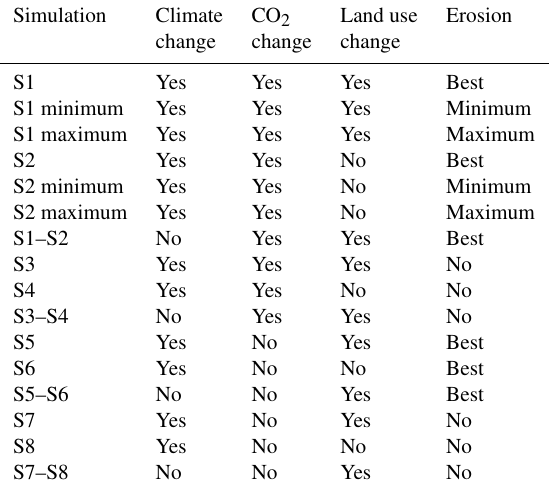
Table 1. Description of the simulations used in this study. The S1 simulation is also the control simulation (CTR). S1 and S2 mini- mum and maximum are the sensitivity simulations using minimum or maximum soil erosion rates. “Best” stands for the best estimated soil erosion rates using optimal values for the R and C factors of the Adj.RUSLE